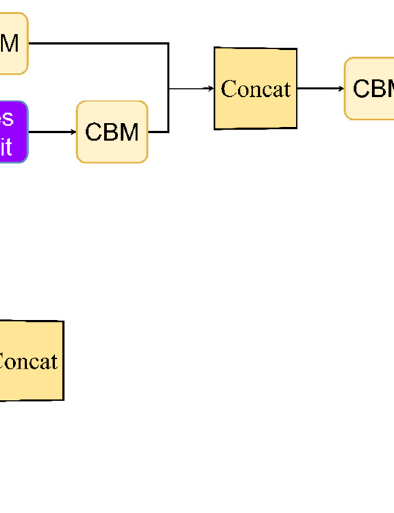
Figure 3. Res unit module.